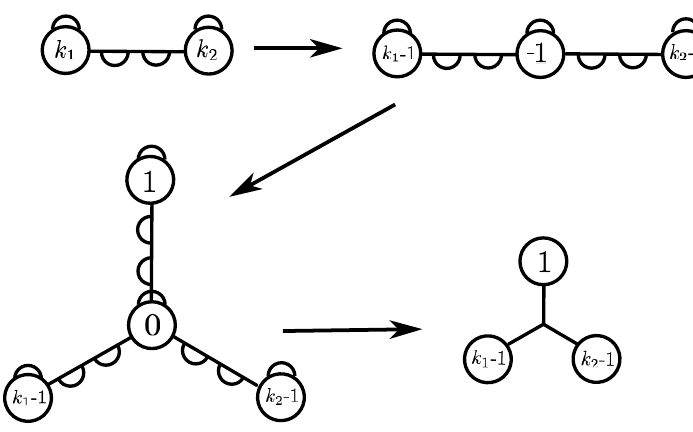
Figure 5 . Sequence of moves leading to the duality between the FT ( G ) theory and a trinion theory with one G symmetry gauged with level 1 CS term. In the last step with use the star-shaped quiver description of the trinion of